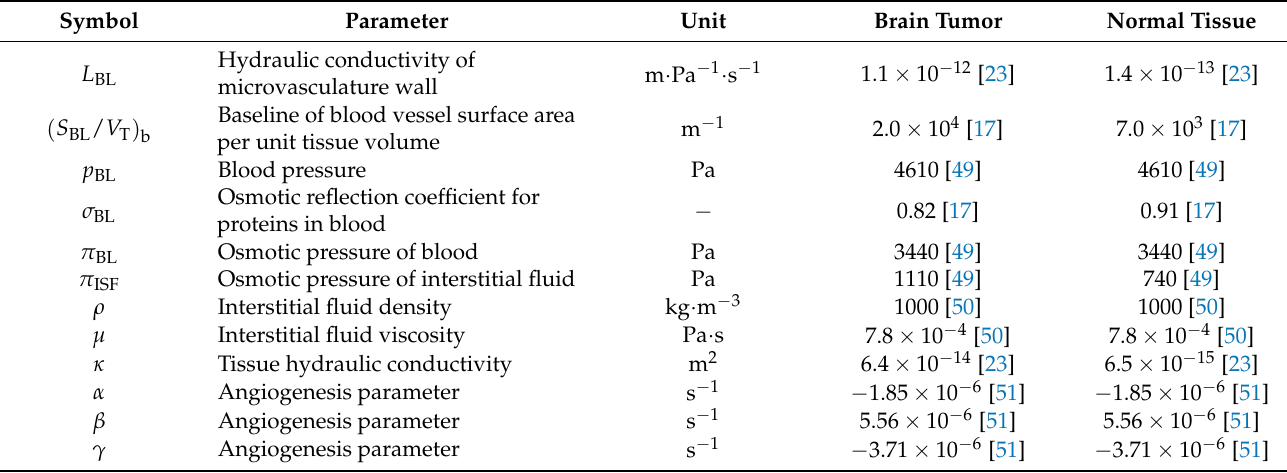
Table 3. Biological properties of brain tumor and surrounding normal tissue.